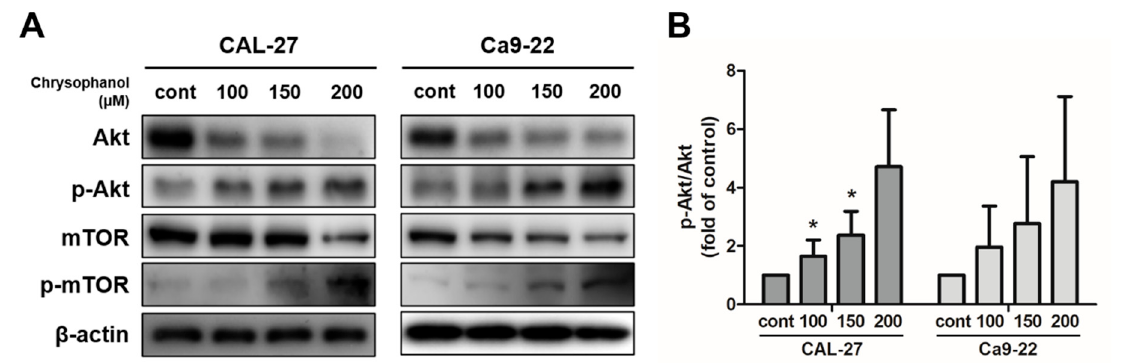
Figure 6. Chrysophanol enhanced the Akt/mTOR pathway in CAL-27 and Ca9-22 cells. ( A , B ) Chrysophanol was applied at 0 to 200 μ M for 24 h in both OSCC cells. The expression of levels of Akt, p-Akt, mTOR, and p-mTOR were obtained using Western blot analysis and the p-Akt/Akt Western blot band density ratio is shown in the histogram. β -actin was used to present loading controls. Data are expressed as mean ± SD (* p < 0.05).